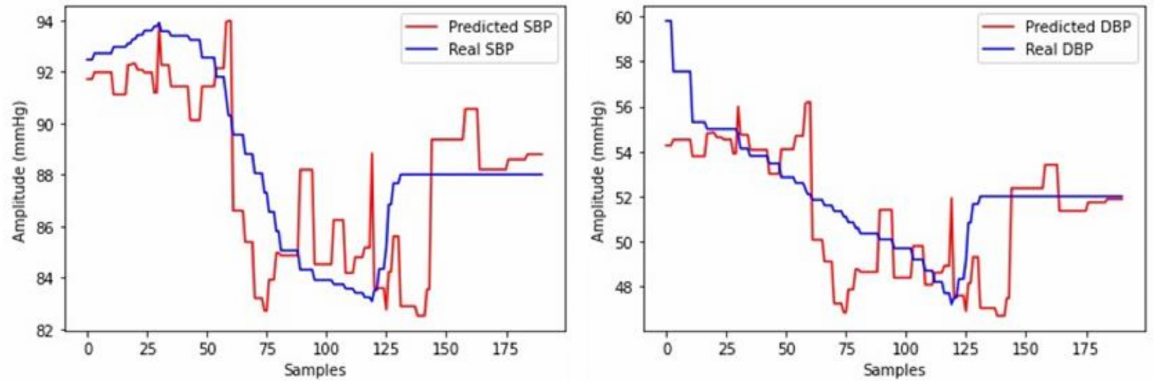
Figure 18. Comparison between real and predicted SBP and DBP values obtained with the linear regressor. MAE SBP = 1.84 ± 3.28 mmHg, MAE DBP = 1.58 ± 2.71 mmHg. These values belong to a 23-year-old woman (subject 1).